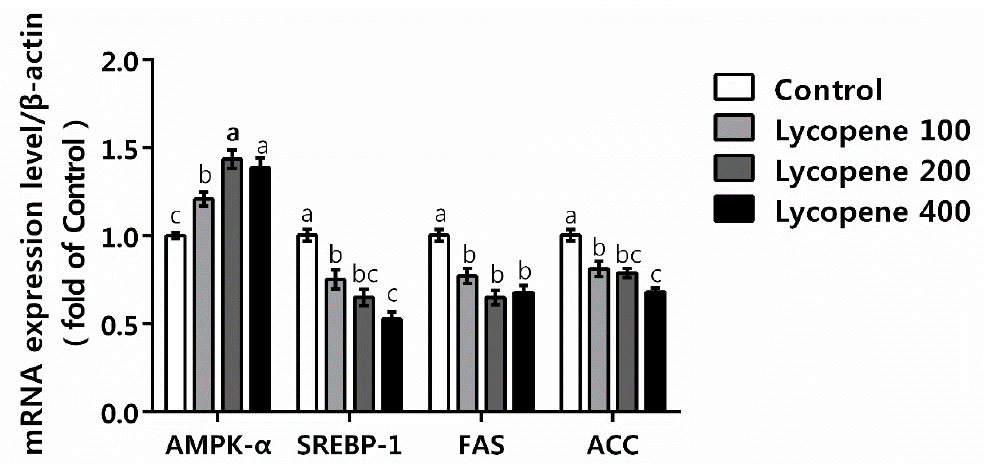
Figure 1. Effects of lycopene on hepatic mRNA expression level of genes in broiler chickens. Values are presented means±standard error of the means, n = 8. Bars with different letters differ significantly (p<0.05). Control, broiler chickens fed basal diet; Lycopene 100, broiler chickens fed ba - sal diet supplemented with 100 mg/kg lycopene; Lycopene 200, broiler chickens fed basal diet supplemented with 200 mg/kg lycopene; Lycopene 400, broiler chickens fed basal diet supplemented with 400 mg/kg lycopene; AMPKα, adenosine monophosphate activated protein kinase α; SREBP-1, sterol regulatory element-binding protein 1; FAS, fatty acid synthase; ACC, acetyl-CoA carboxylase.